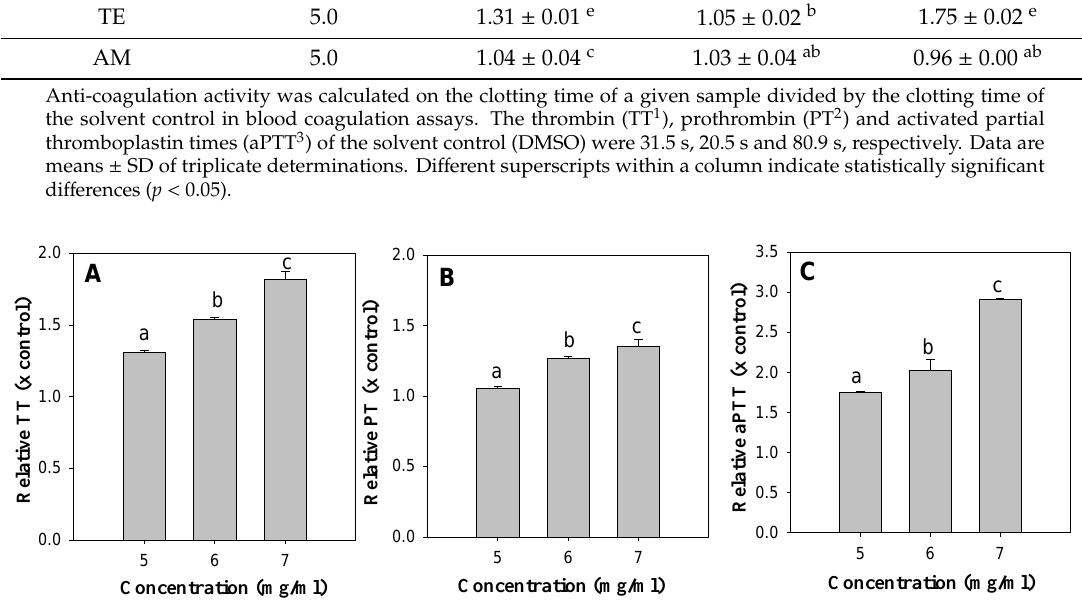
Figure 1. The concentration-dependent anti-coagulation activities of TE extract. A : TT changes by TE extract, B : PT changes by TE extract, C : aPTT changes by TE extract. Different superscripts within a panel indicate statistically significant differences ( p < 0.05).